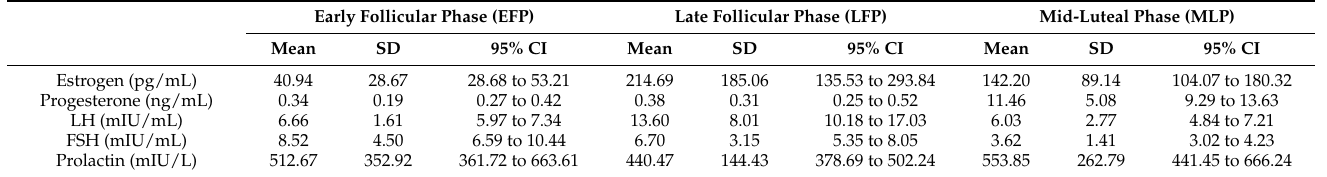
Table 2. Concentration of sex hormones in the three phases of the menstrual cycle.